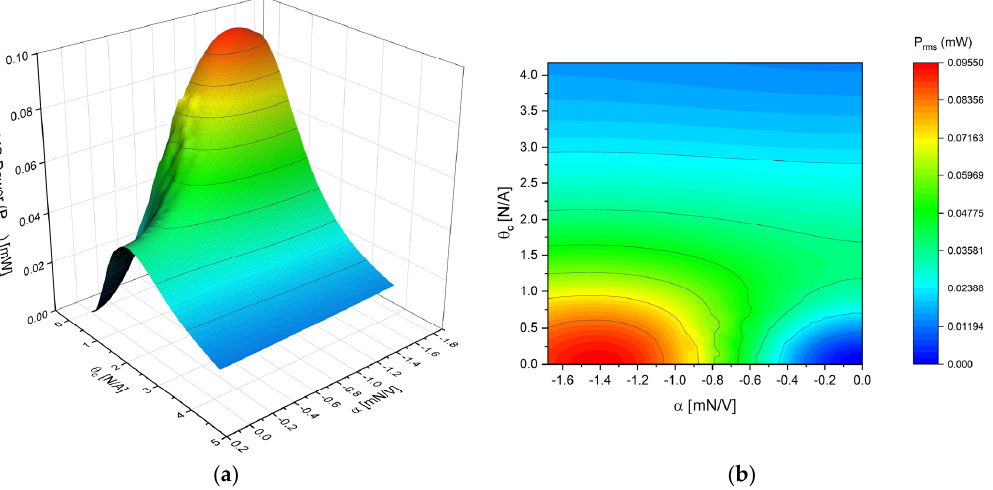
Figure 12. The effect of coupling coefficients on the harvester power. ( a ) The rms power of the harvester versus the coupling coefficients; ( b ) contour plot of the output power.